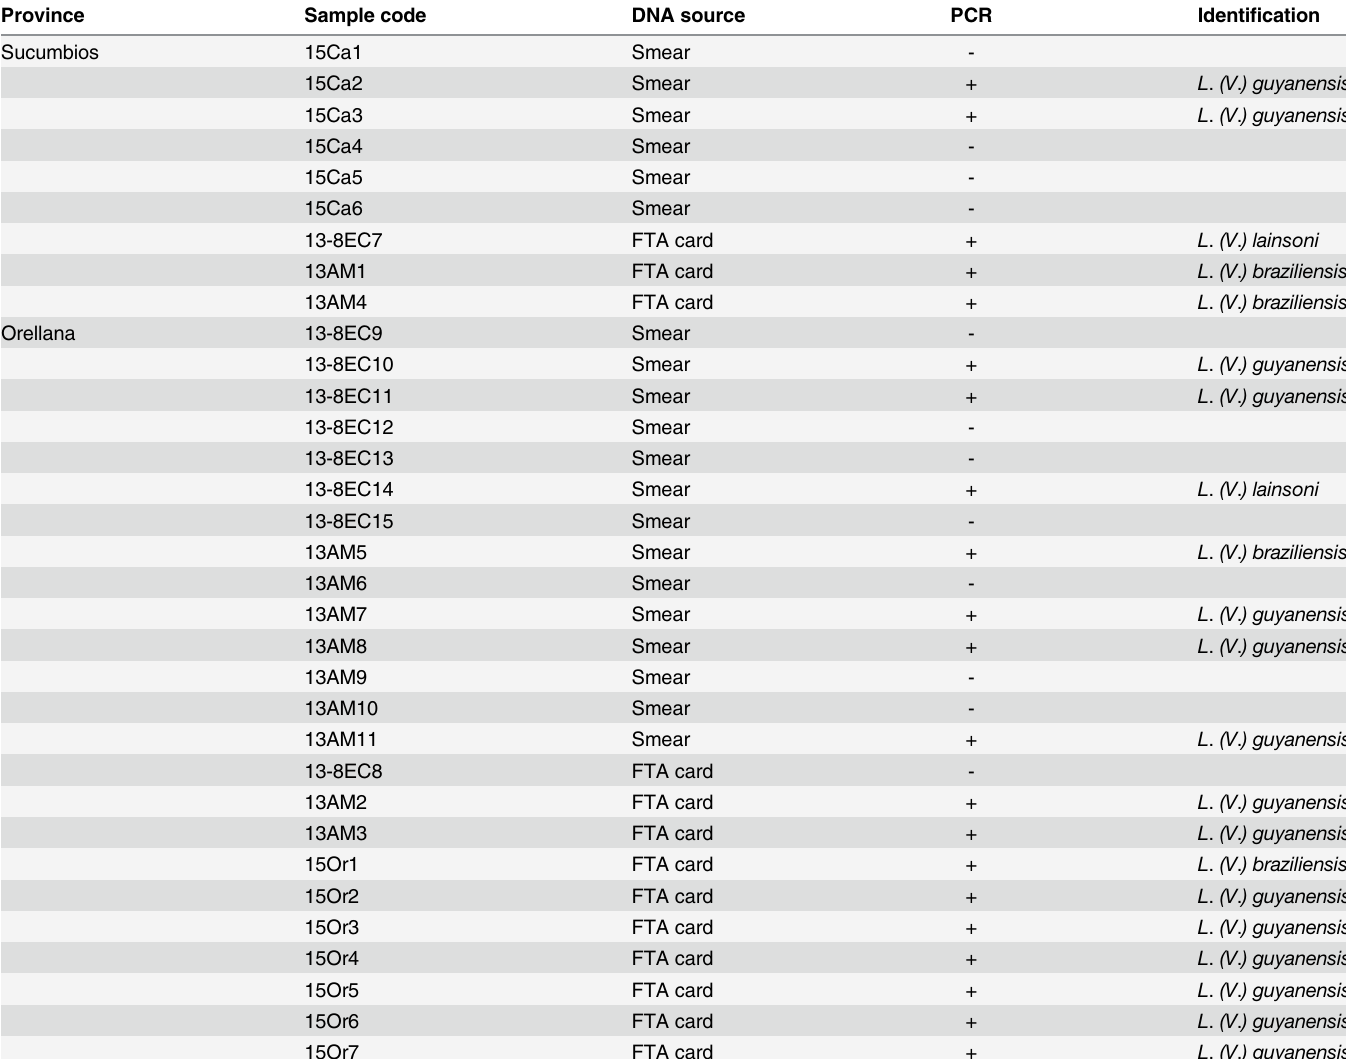
Table 1. Identification of Leishmania species from patient specimens.